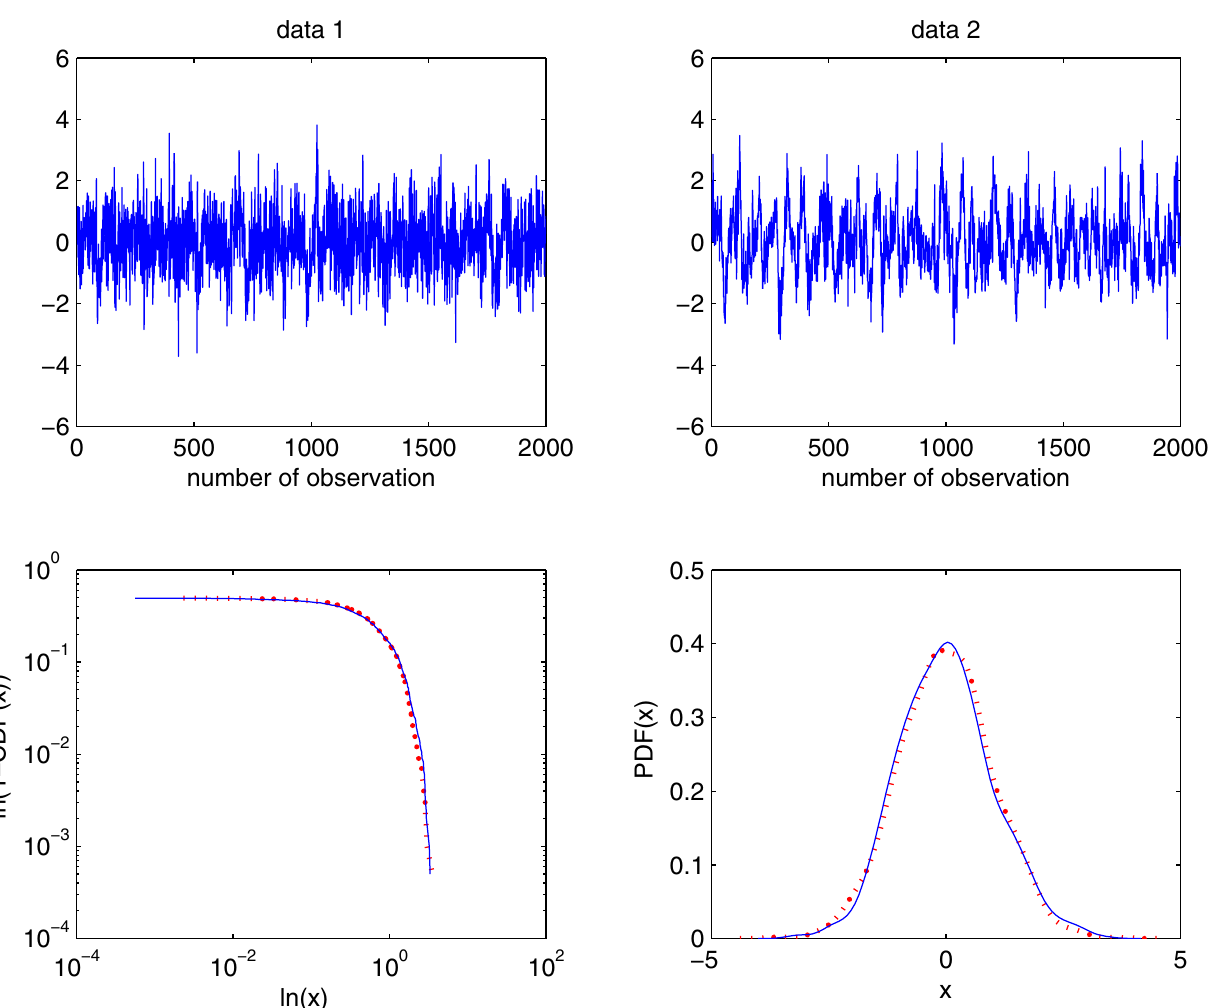
Fig 13. Plasma data for the torus radial position r = 9.6 cm: data1 (top left panel), data2 (top right panel), and their empirical tails (bottom left panel) and PDFs (bottom right